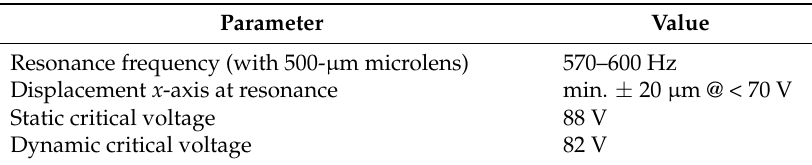
Figure 14. Electrostatic z-axis scanner: ( a ) construction; and, ( b ) modeling results (Intellisuite)—first resonance mode (piston) of spring suspensions. Table 3. Expected parameters of z-scanner.